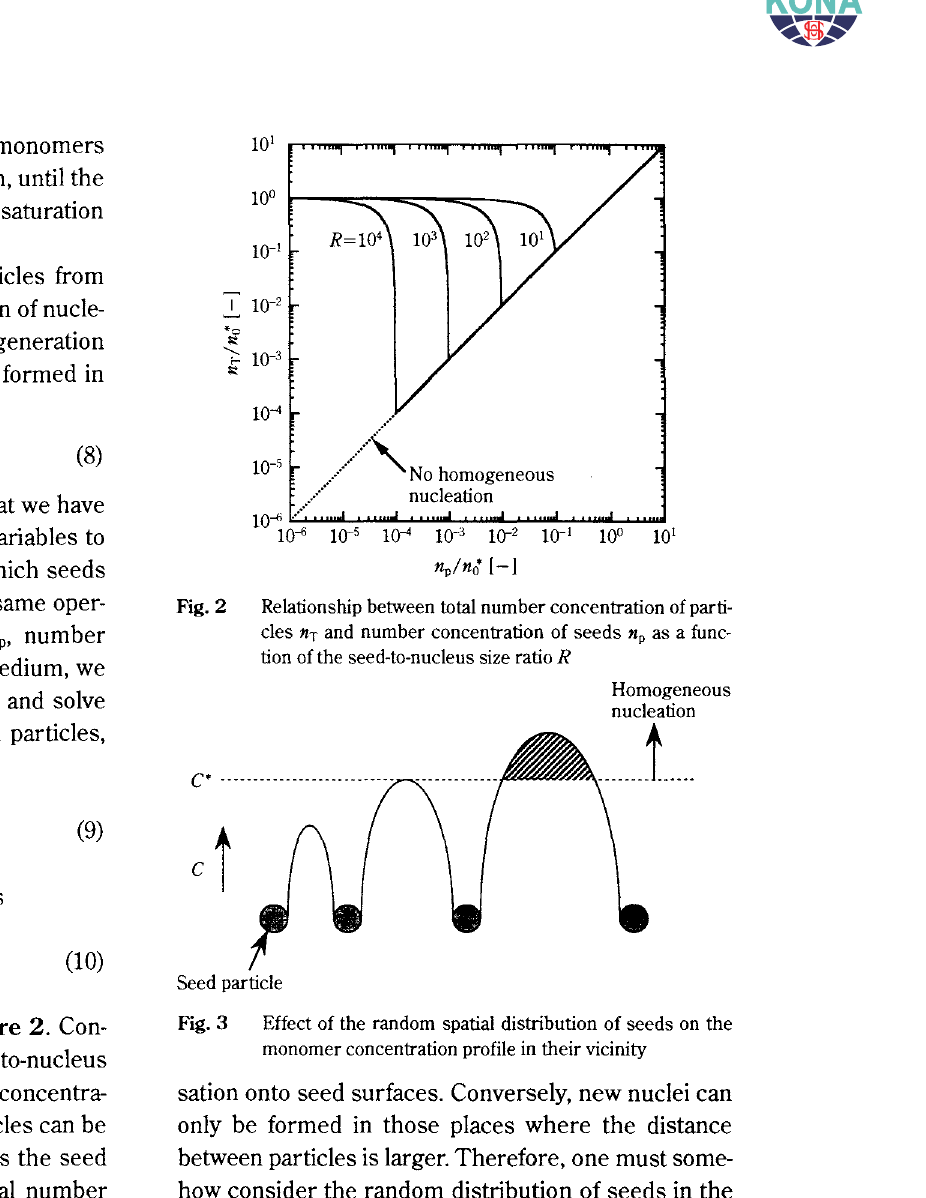
Homogeneous nucleation